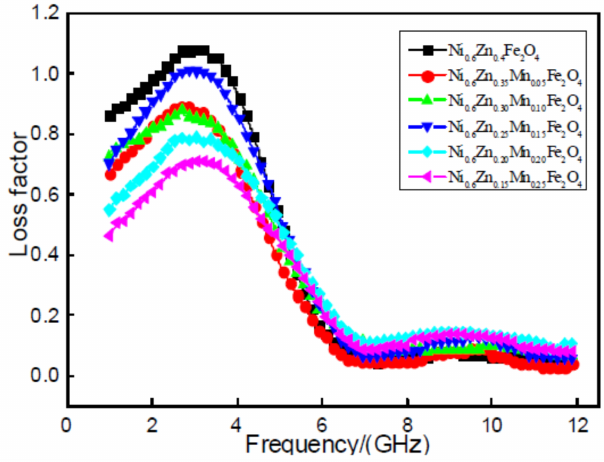
Figure 7. Curves of tan δ and frequency for the Ni 0.6 Zn (0.4 − x) Mn x Fe 2 O 4